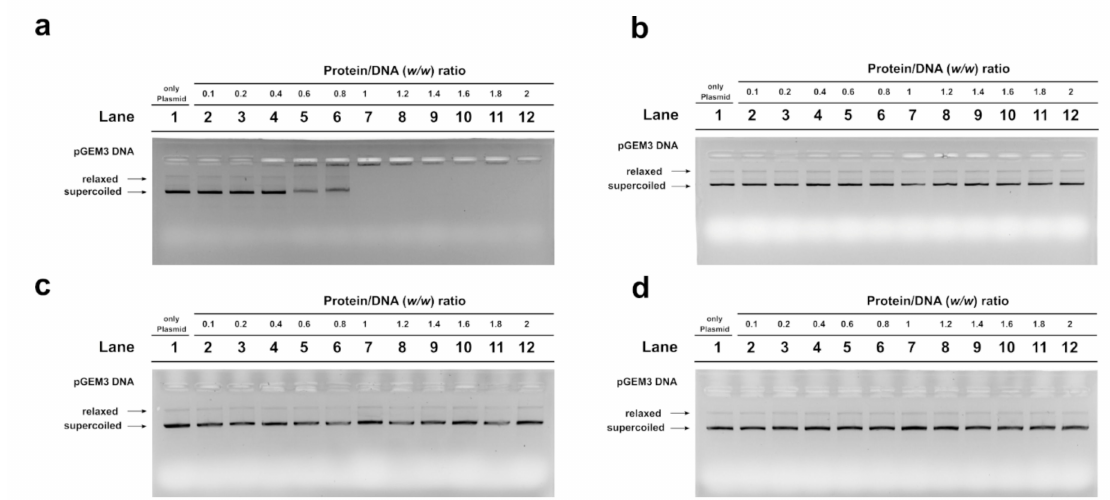
Figure 4. Electrophoretic mobility shift assay (EMSA) analyses of DNA binding ability of PL proteins from unexposed ( a ) and 1, 10, and 100 pM HgCl 2 -exposed mussels ( b – d ), using plasmid DNA. Numbers on the wells indicate the PL protein/DNA ( w / w ) ratios used; only plasmid denotes pGEM3 plasmid DNA with no proteins